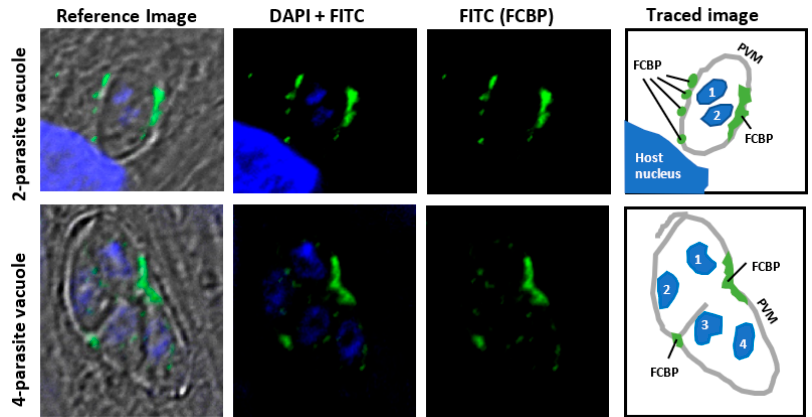
Figure 5. Membrane location of Toxoplasma gondii FCBP (TgFCBP). Human foreskin fibroblast (HFF) cells were grown in monolayer on coverslips, and asynchronously infected with T.